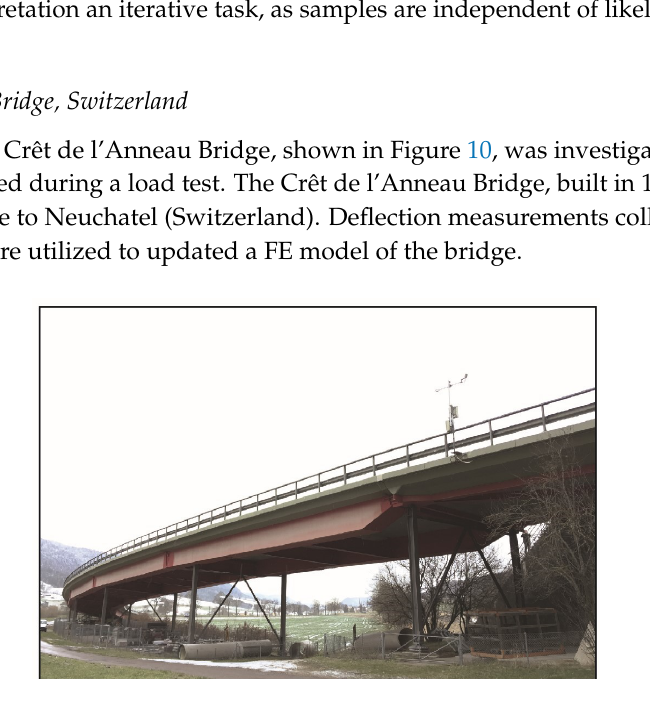
Figure 10. Crêt de l’Anneau Bridge near Neuchatel